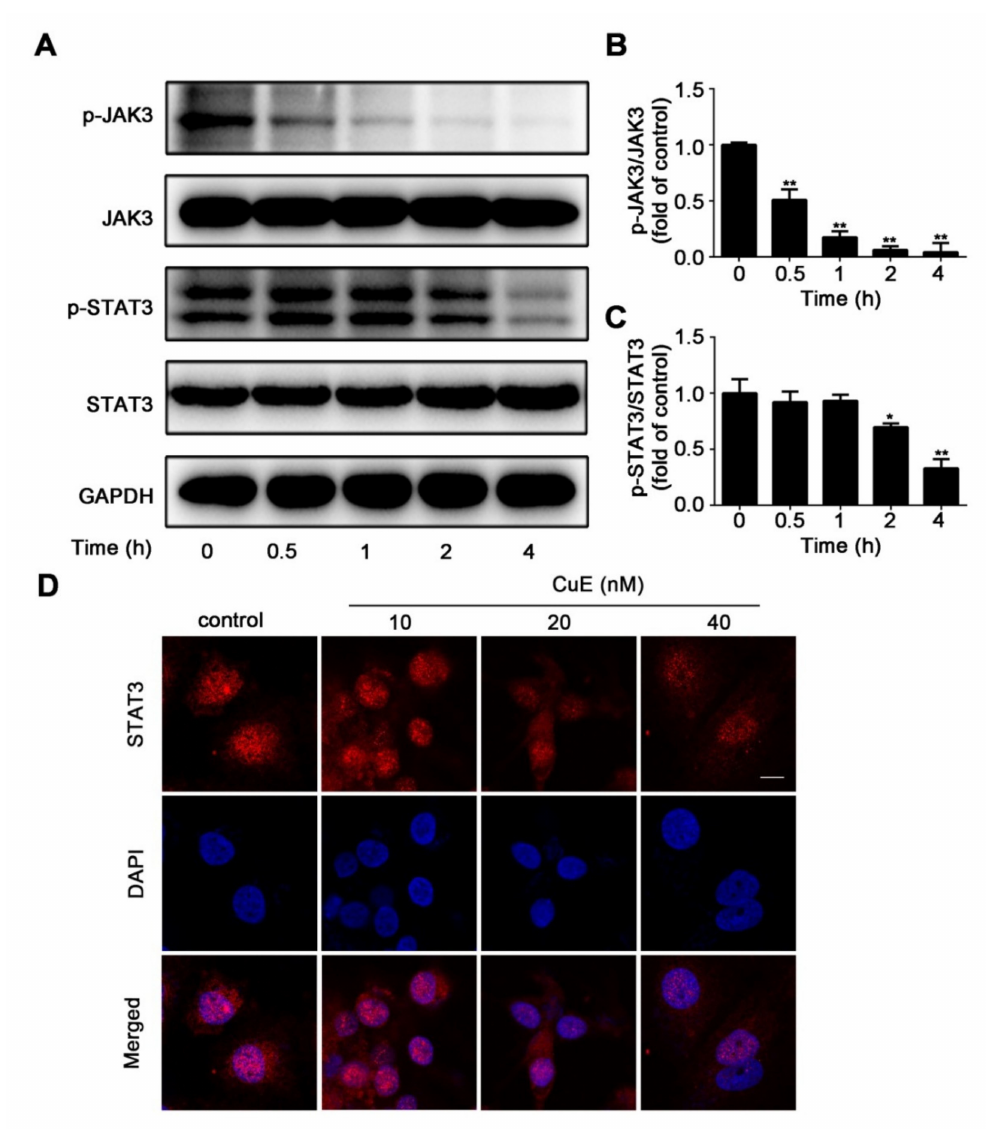
Figure 5. CuE restrained the activation of JAK3 and STAT3 in Huh7 cells. Cells were treated with CuE (40 nM) for various hours. ( A ) Phosphorylations of JAK3 and STAT3 protein were determined by Western blotting. ( B - C ) Quantitative analysis for relative phosphorylation levels of JAK3 ( B ) and STAT3 ( C ) was performed by normalizing to the control group. Data are mean ± SD of three independent experiments (n = 3). *: p < 0.05, **: p < 0.01, compared with the control group. ( D ) E ff ect of CuE on nuclear translocation of p-STAT3 in Huh7 cells. Immunofluorescent analysis was conducted with antibody of p-STAT3 and secondary antibody conjugated to rabbit Dylight-594. Images were captured using a confocal laser scanning